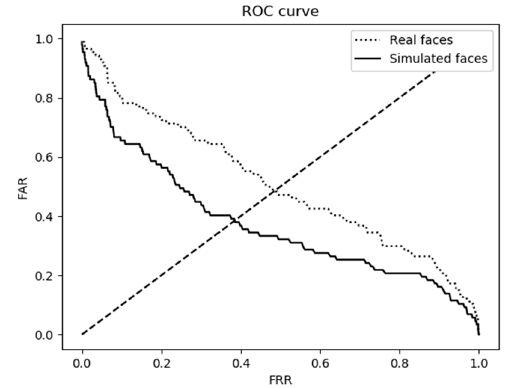
Figure 8. Receiver operating characteristic (ROC) curves of the 3D facial verification system.